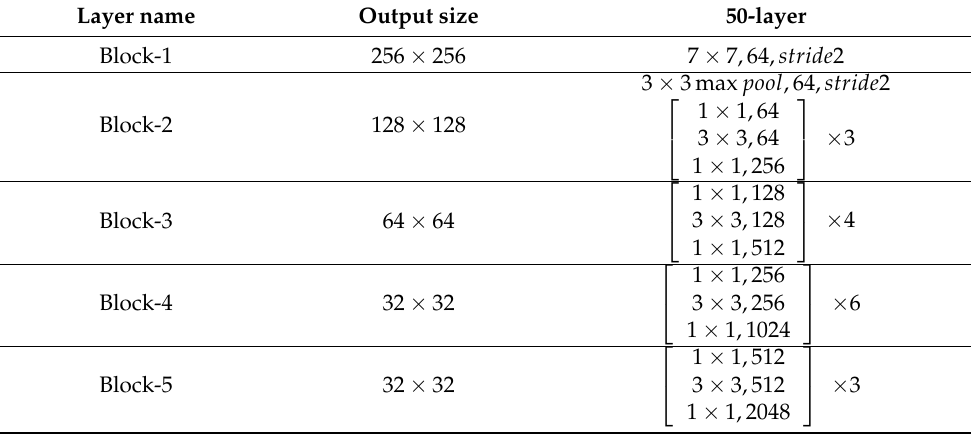
Figure 1. The architecture of Multi-level Feature Aggregation Network (MFANet). The modified ResNet-50 is used to extract features of different levels. Then the deep semantic features are further extracted by Channel Feature Compression (CFC), the feature fusion and location recovery are completed by Multi-level Feature Attention Upsample (MFAU), and the recovered high-resolution details are further refined by Channel Ladder Refinement (CLR). The blue and red lines represent down sampling and up sampling operations respectively. Table 1. An explanation of five Blocks from the extraction network ResNet-50 . Note that the stride of Block-5 is reset to